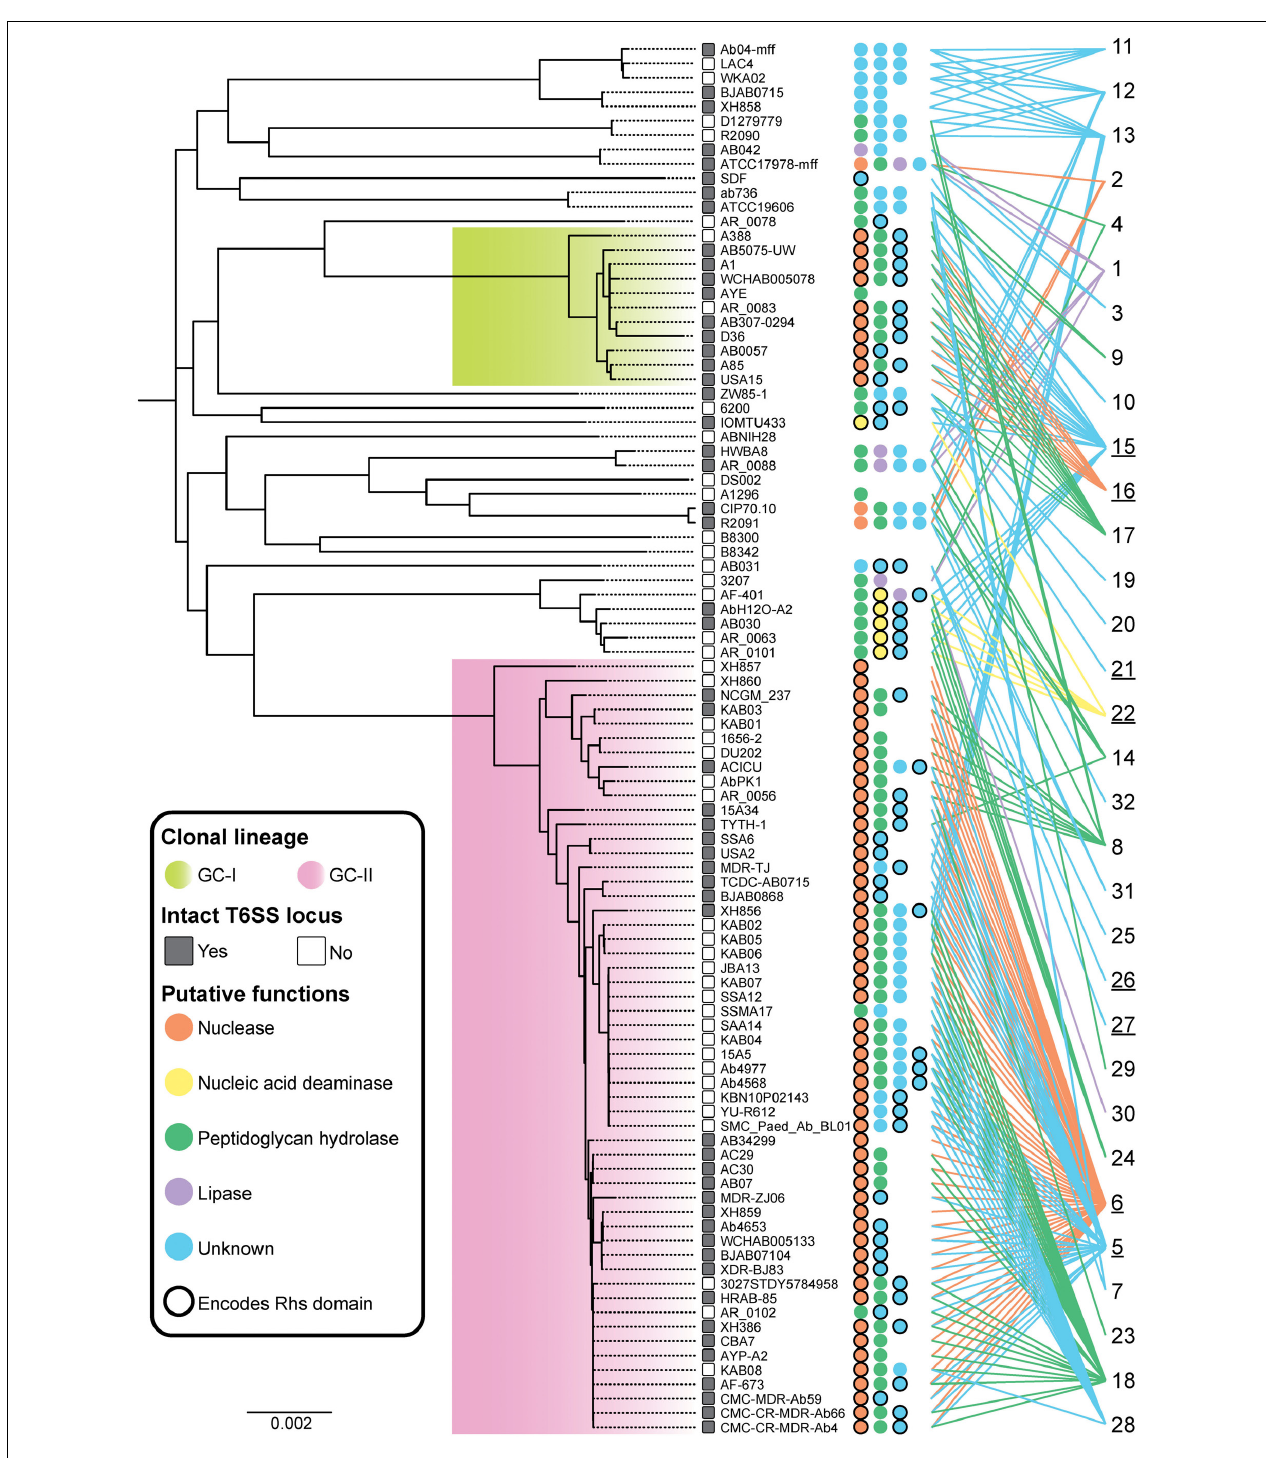
FIGURE 4 | Effector conservation in A. baumannii . Distribution of T6SS effectors across the A. baumannii strains examined in this study. The ML phylogenetic tree (left) was generated using whole genome sequences representing 97 strains. The scale bar represents the genetic distance between strains as measured by the number of single nucleotide polymorphisms (SNPs). Strains enclosed by the green box include global clone I (GC-I) strains, and strains enclosed by the pink box include global clone II (GC-II) strains. The number of predicted effectors encoded by each strain is indicated by the number of colored circles adjacent to the strain name. The color of each circle represents the predicted function of each effector as follows; orange, nuclease; yellow, nucleic acid deaminase; green, peptidoglycan hydrolase; purple, lipase; blue, unknown function. A black border around a circle indicates that an RHS domain is present within the N-terminal region of the effector. The designated number for each effector group is shown at the far right with an underscore indicating those effector groups that have an N-terminal RHS domain. Colored lines are provided to link each effector group to the strains where a representative is found.